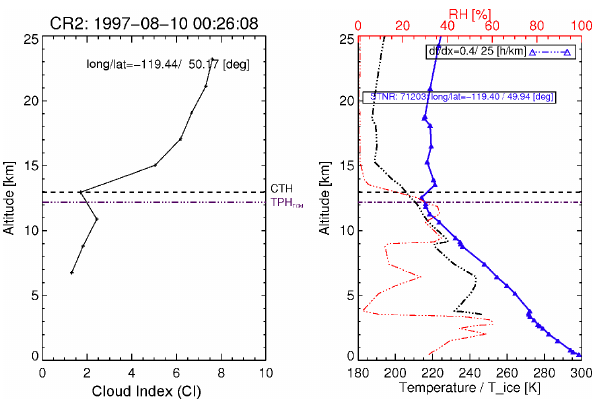
Figure 2. Cloud index (CI) profile during CRISTA-2 (left) and co- incident radiosonde measurements (right) at midlatitudes. The pro- files on the right side show temperature (blue) and relative humid- ity (red). The ice saturation temperature curve is superimposed as the black dash-dotted curve. Horizontal lines indicate cloud top height (CTH) from the CRISTA measurements (dashed) and the so-called “high-resolution” tropopause height (TPH hr ) from ERA Interim temperature data (dash-dotted); for details see Sect.